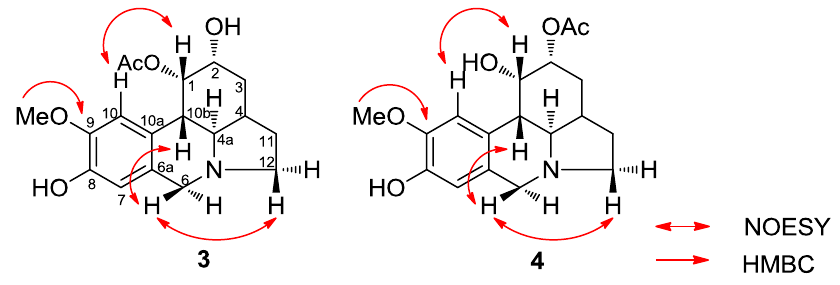
Figure 4. Key NOESY correlations of compounds 3 and 4 . Table 3. NMR data for compounds 3 and 4 (400 MHz for 1 H and 100 Hz for 13 C, CDCl 3 ).